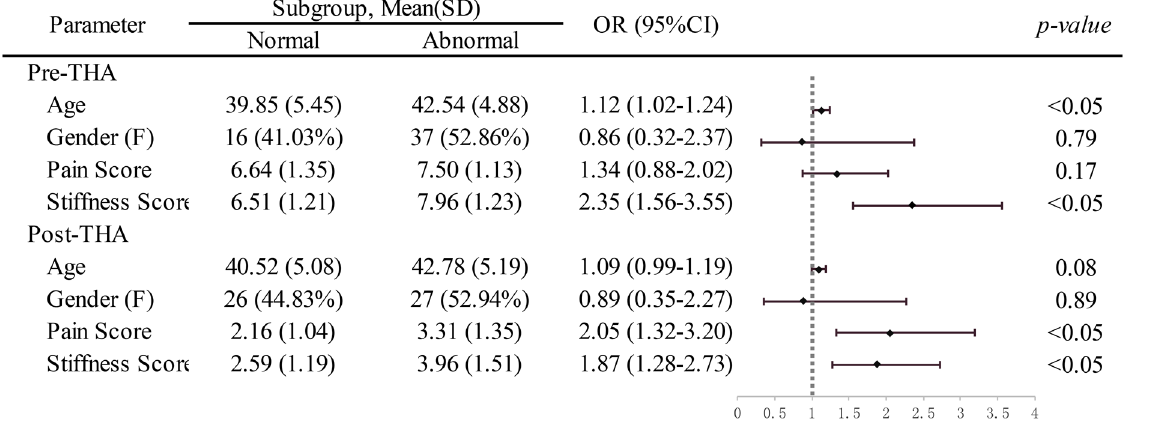
OR: odds ratio; 95%CI: 95% con fi dence interval; F: